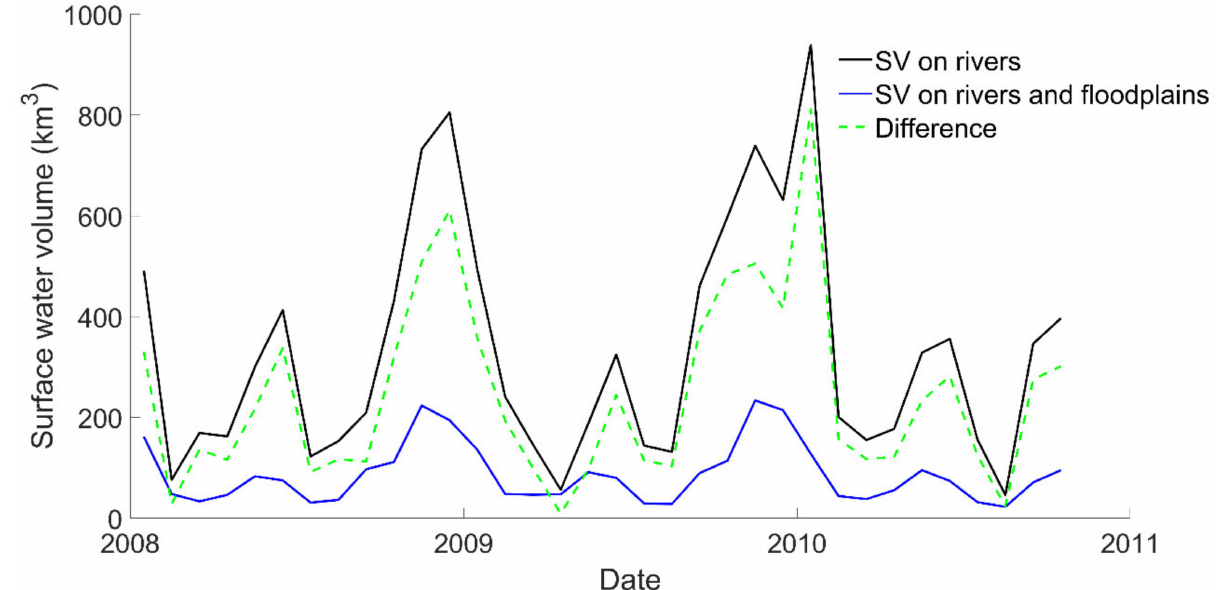
Figure 9. Time series of surface water storage of the Cuvette Centrale of Congo obtained combining the surface water extent and the time series of water levels from the ENVISAT VSs on the rivers (black), on the rivers and floodplains (blue). Their difference is presented in dashed